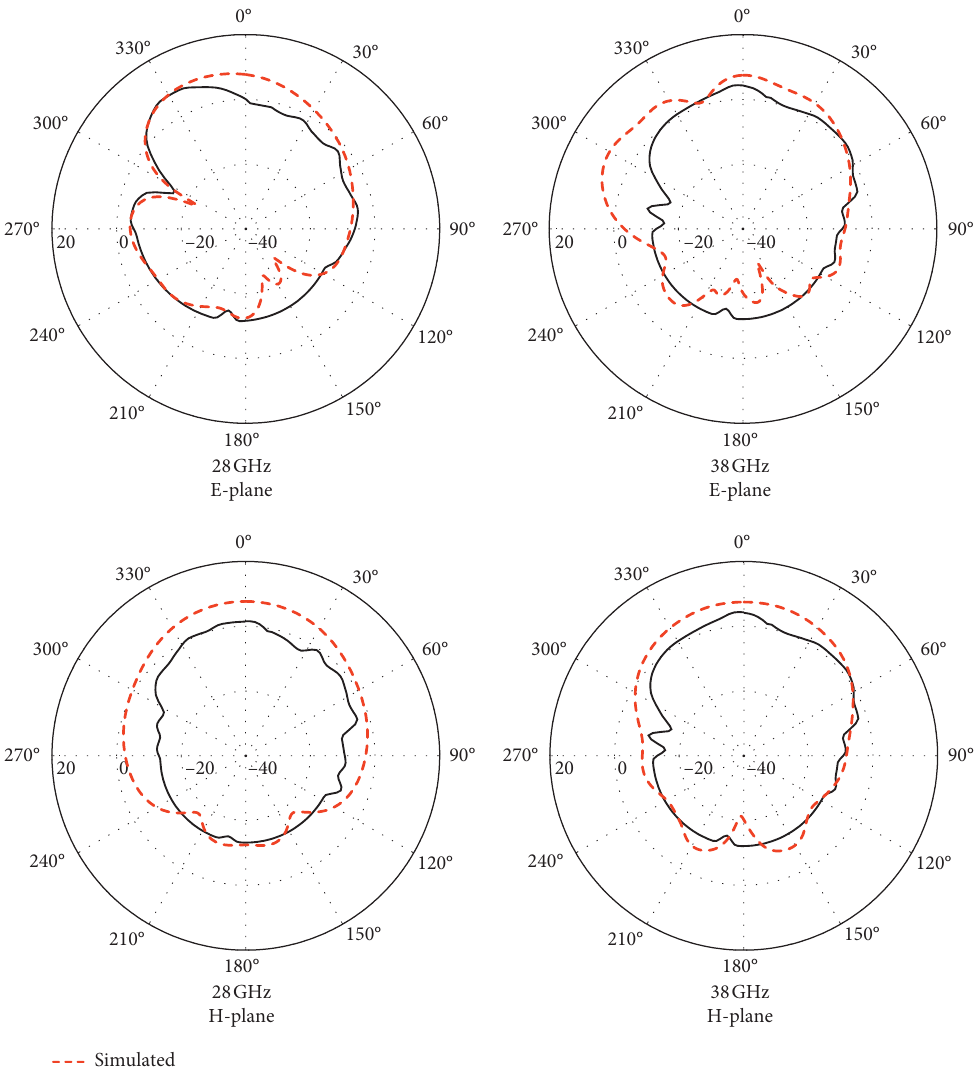
Figure 8: Simulated and measured radiation patterns of the proposed unit element (unit: